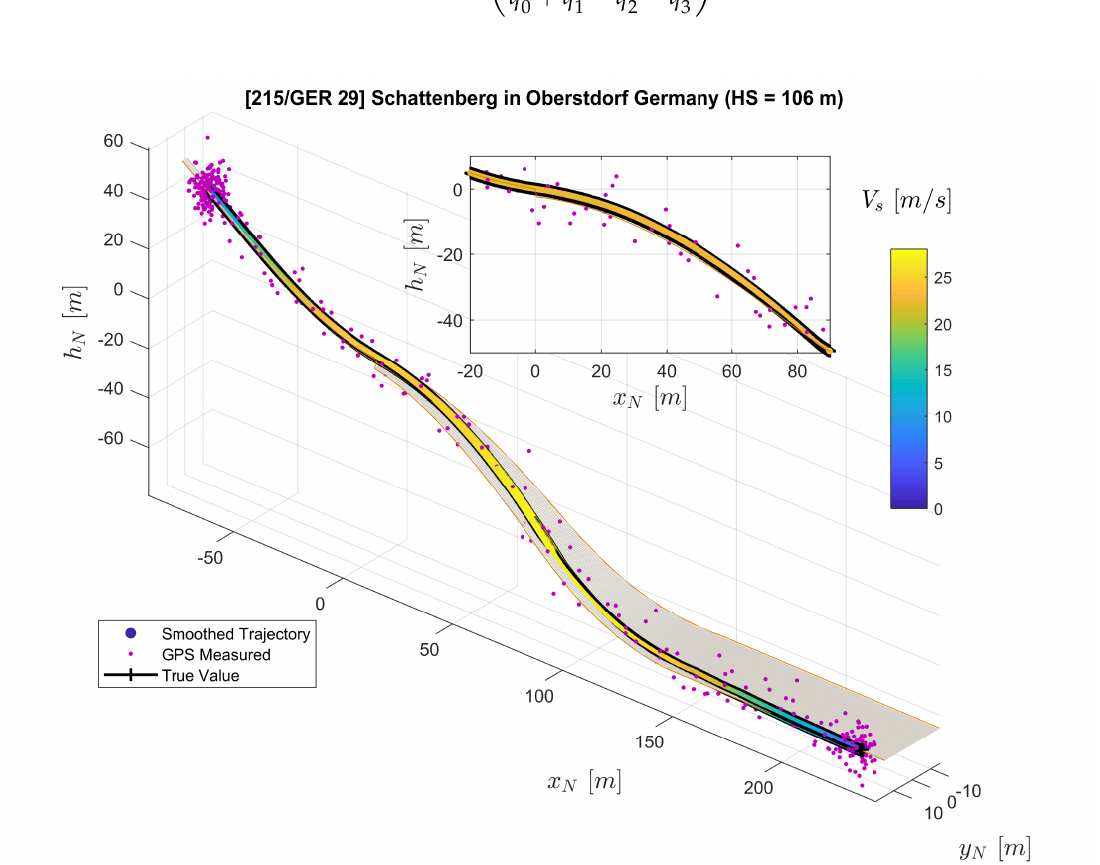
Figure 5. Comparison of the extended RTS smoother reconstructed trajectory (color-coded line), the generated reference trajectory (black line), and the GPS measured trajectory (purple dots) plotted on the ski jumping hill model.